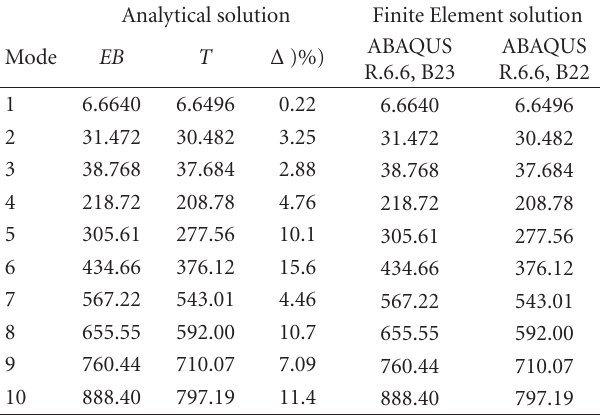
Table 10: First ten natural frequencies (Hz); see Table 7; θ 2,3 = 90 ◦ , − 90 ◦ .